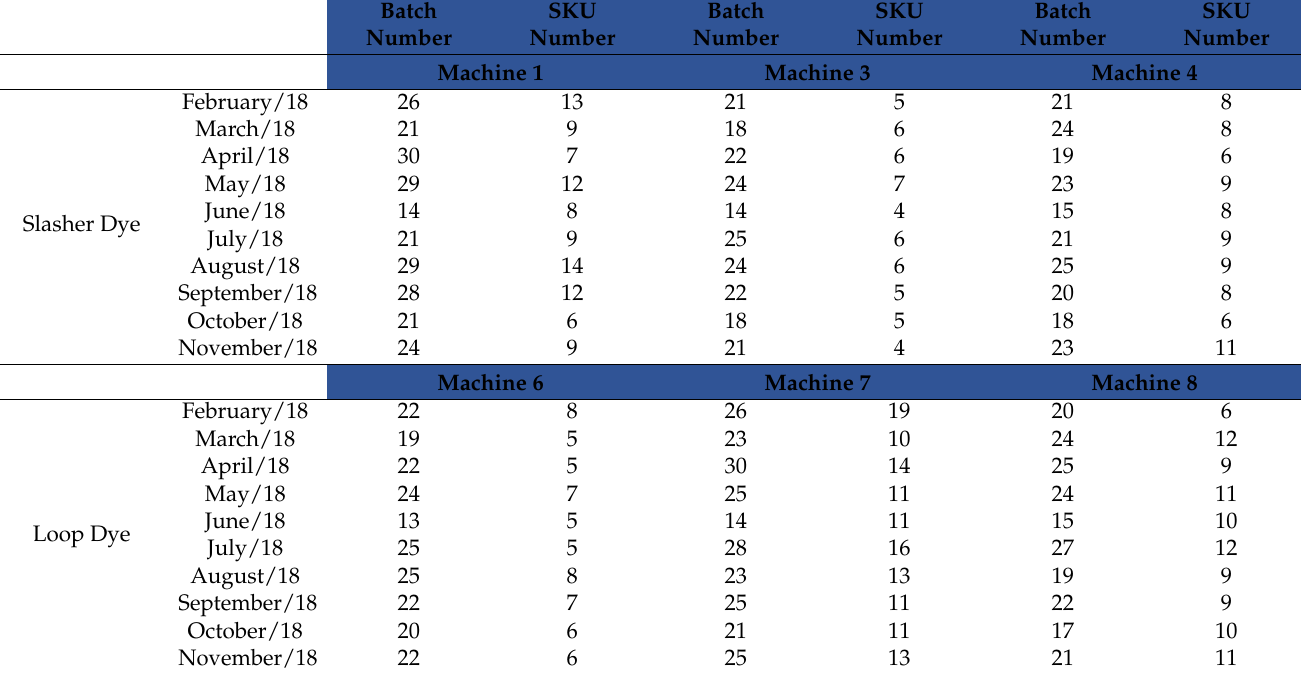
Table 1. Number of processed